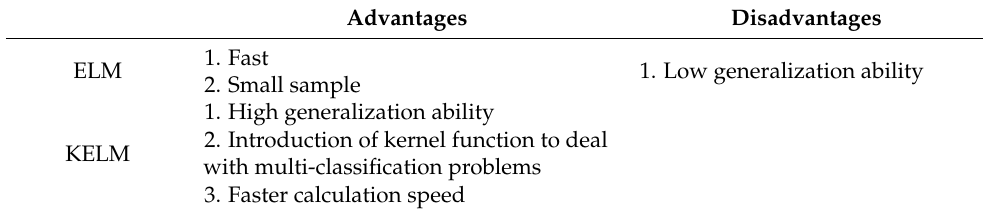
Table 2. The advantages and disadvantages of the KELM and ELM.